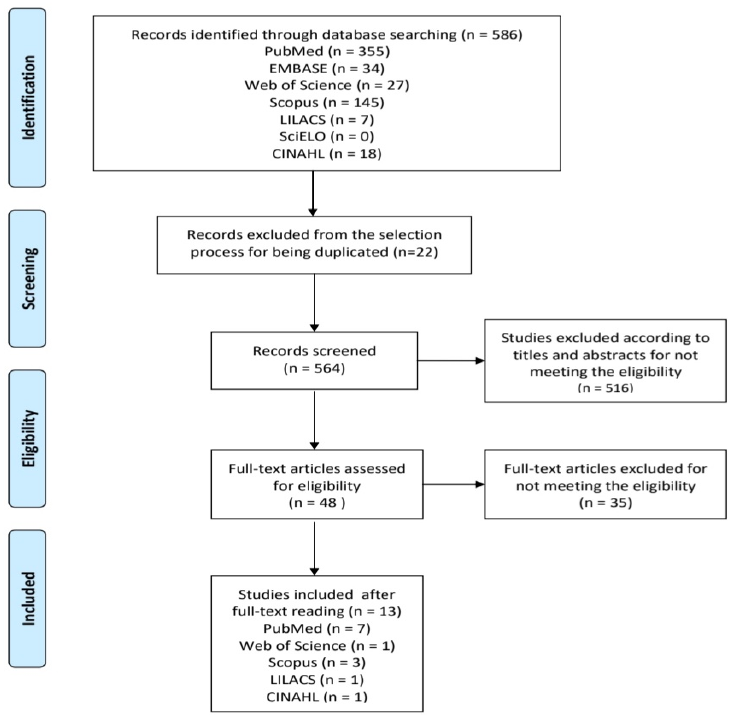
Figure 1. Prisma Flowchart, identification, screening, eligibility and inclusion of studies.